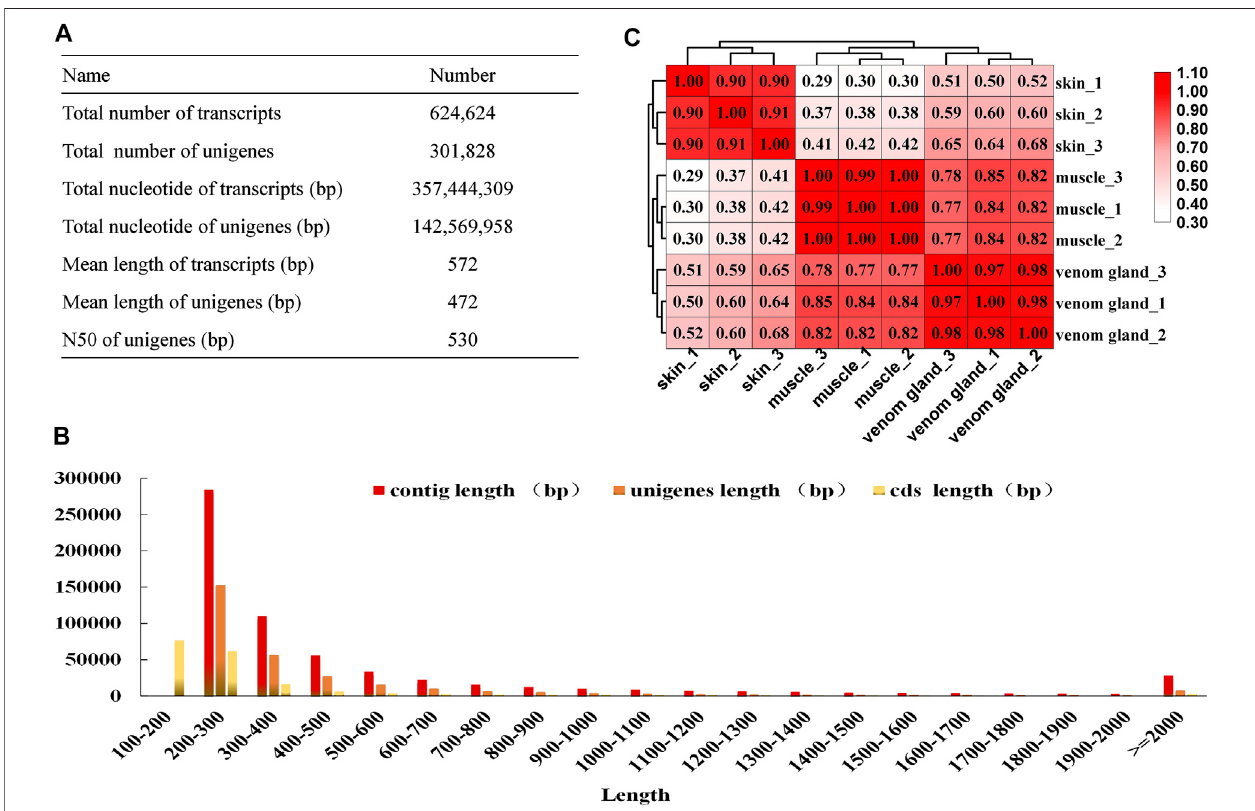
FIGURE 1 | Illumina sequencing of different tissues of B. bufo gargarizans . (A) The results of the assembly sequences. (B) Pearson ’ s correlation coef fi cients of the biological replicates among three tissues. (C) The length distribution of contigs, unigenes, and CDSs.